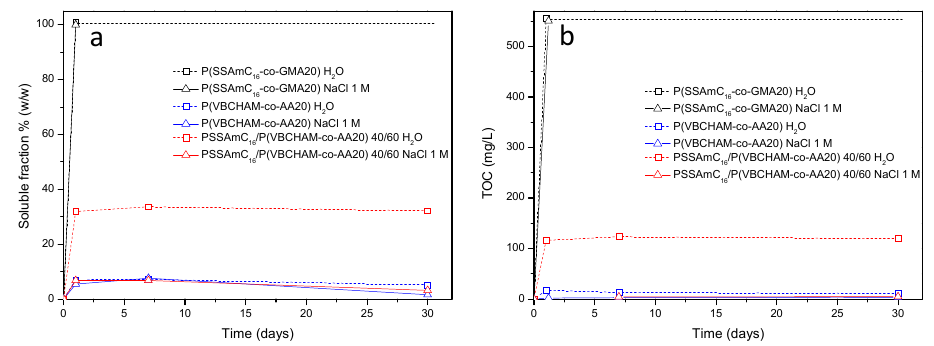
Figure 1. ( a ) Evolution of the soluble fraction % ( w / w ) after immersion of P(SSAmC 16 ‐ co ‐ GMA20), P(VBCHAM ‐ co ‐ AA20) and PSSAmC 16 /P(VBCHAM ‐ co ‐ AA20) 40/60 w / w polymeric coatings in ultra ‐ pure water and aqueous NaCl 1 M solution for different time periods; and, ( b ) Evolution of the total organic carbon (TOC) values of the solutions for the same studies.